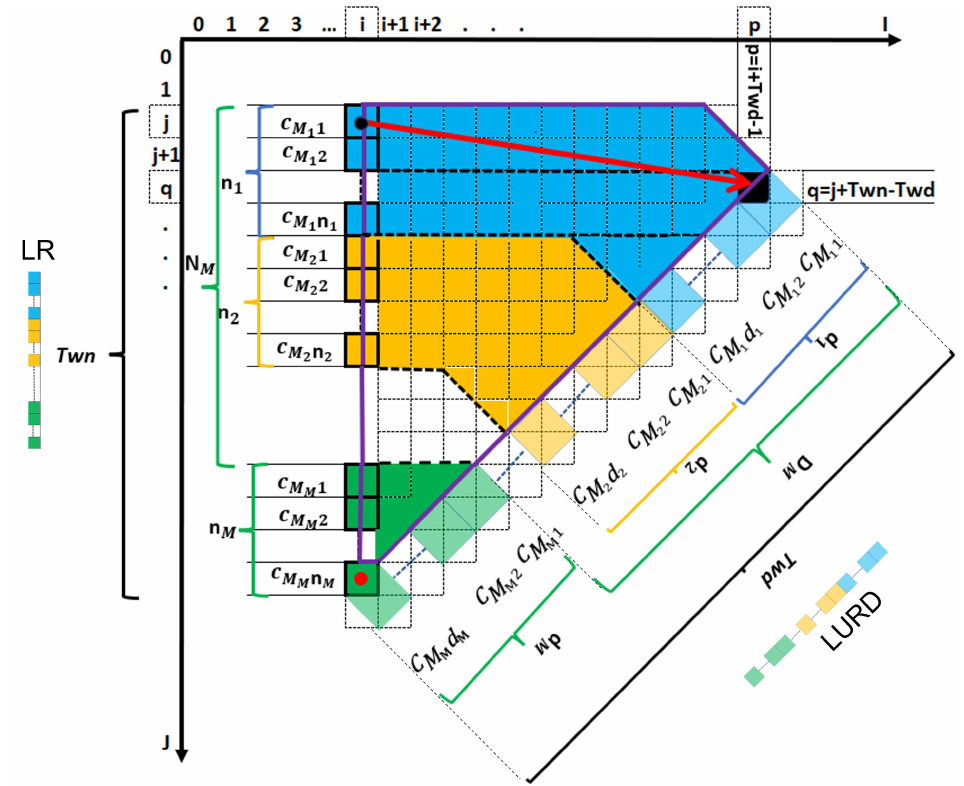
Figure 5. Two moving neighborhoods, LR and LURD, and the turning neighborhood, LRtoLURD, which fills the gap between them are shown here. The corresponding edge related to LRtoLURD is the red arrow. The reference cell of LR at cell ( i , j ) and its opposite are shown by the black and red dots, respectively. The cost of each cell or block in both input and output is named in the figure. For example C M 1 is the cost of the first cell of the first mode in LR. The number of cells for mode m in 1 LR varies from 1 to n m while for LURD the number of blocks in mode m is between 1 and d m . The reference cell of LURD is located at cell ( p , q )